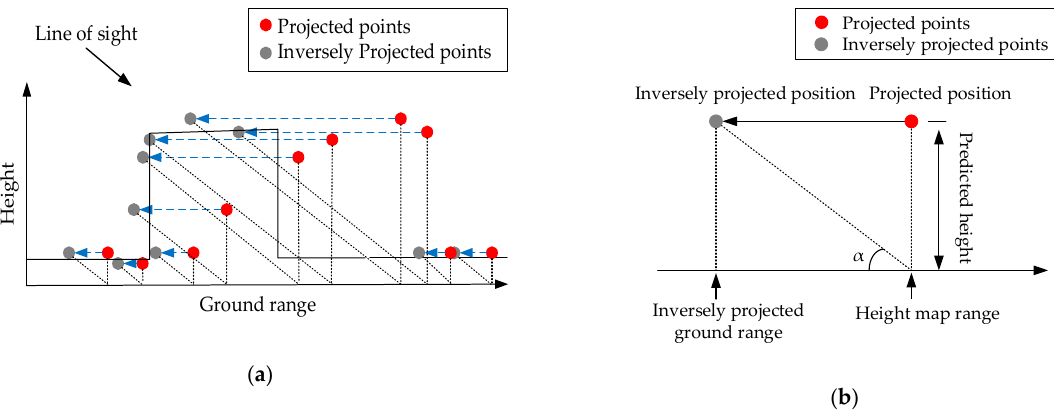
Figure 8. Inverse projection diagram. ( a ) Inverse transformation process of the surface scatterers. Black dotted lines denote the triangle relationship, and blue dotted lines denote the change before and after the inverse projection. ( b ) The triangle relationship between the look-down angle and the predicted point